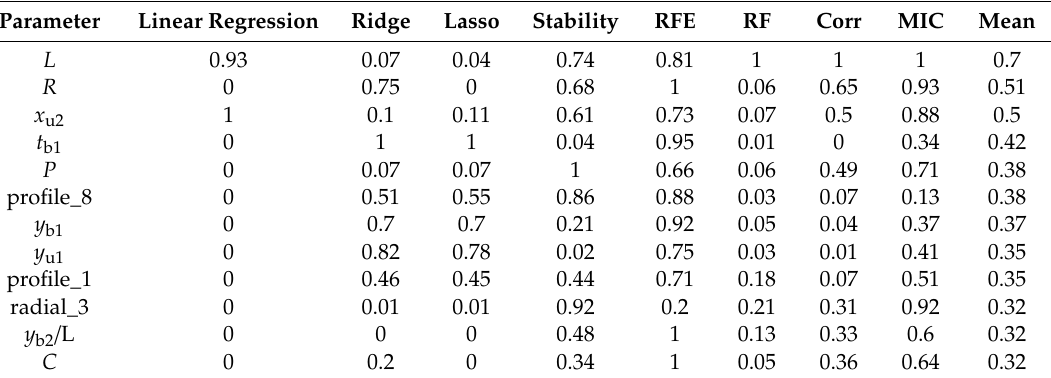
Table 3. Estimation of the measures of significance of spike quantitative characteristics for predicting spike density based on analysis of the images acquired by ‘table’ protocol: characteristics are listed in column 1; significance values, in columns 2–9; and their means, in column 10. The significance measures are described in Methods, Section 2.4.2.